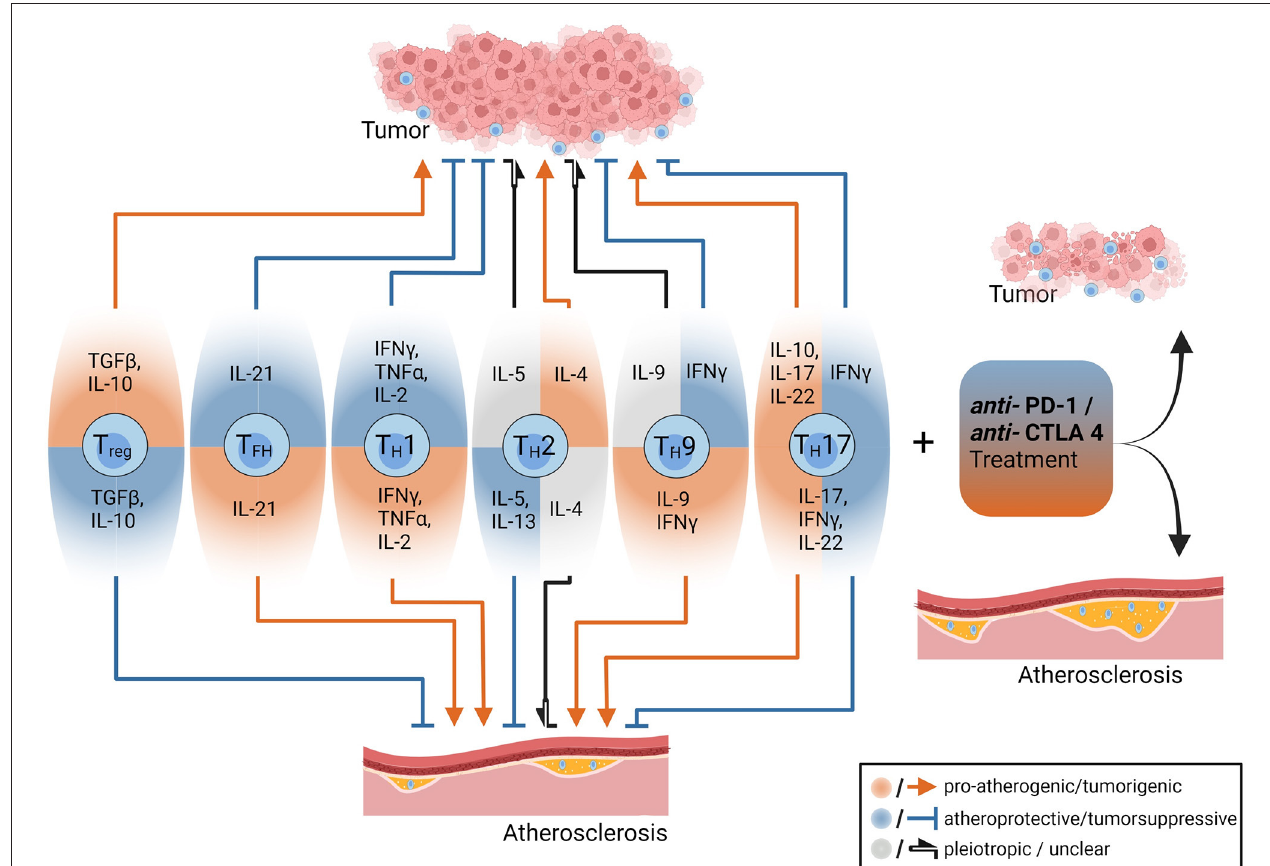
FIGURE 1 | The opposing roles of CD4 + T-cells and anti-PD-1/anti CTL4 treatments in the pathogenesis of tumors and atherosclerosis. CD4 + T cell subsets and their effector cytokines have different roles in tumors and atherosclerosis. Some cytokines such as interferon gamma have pro-atherogenic (red arrow) and tumor-suppressive effects (blue arrow with blunt end), while Interleukin-10 (IL-10) depending on its cellular source exerts anti-atherogenic and tumor-progressive functions. Treatment with immune checkpoint inhibitors (anti-PD1 and anti-CTLA-4 antibodies) reduces tumor burden but drives atherosclerosis among others by enhancing pro-inflammatory T cell effector functions. The figure was created with